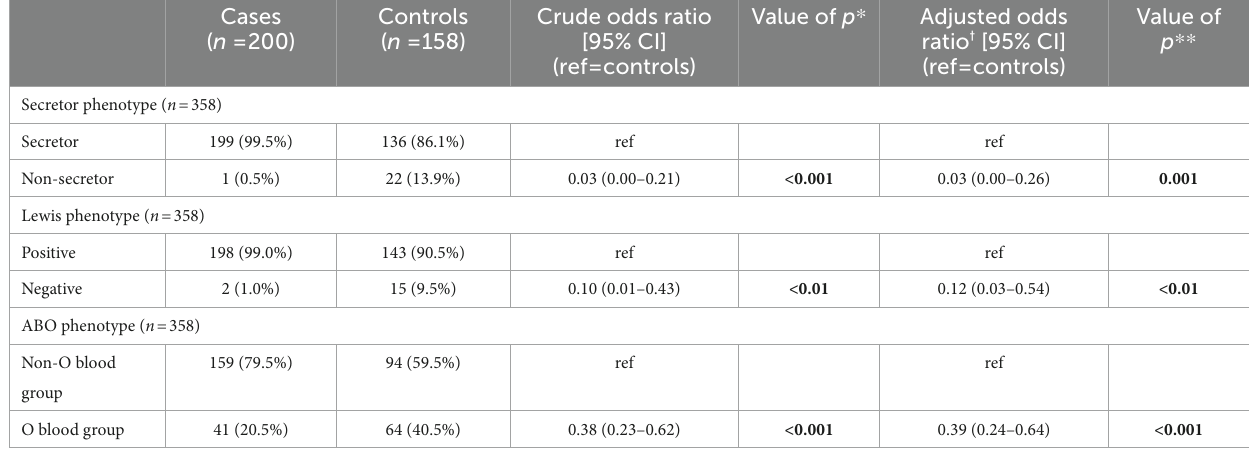
TABLE 4 Crude and adjusted logistic regression analysis shows high impact of histo-blood group antigen (HBGA) polymorphisms between cases and controls in Nantes.